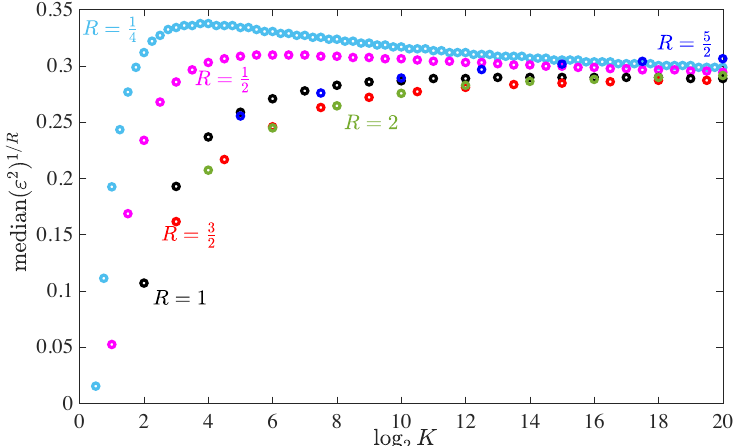
Figure 3. R th root of median total squared error vs. the number of columns K in logarithmic scale for various rates R